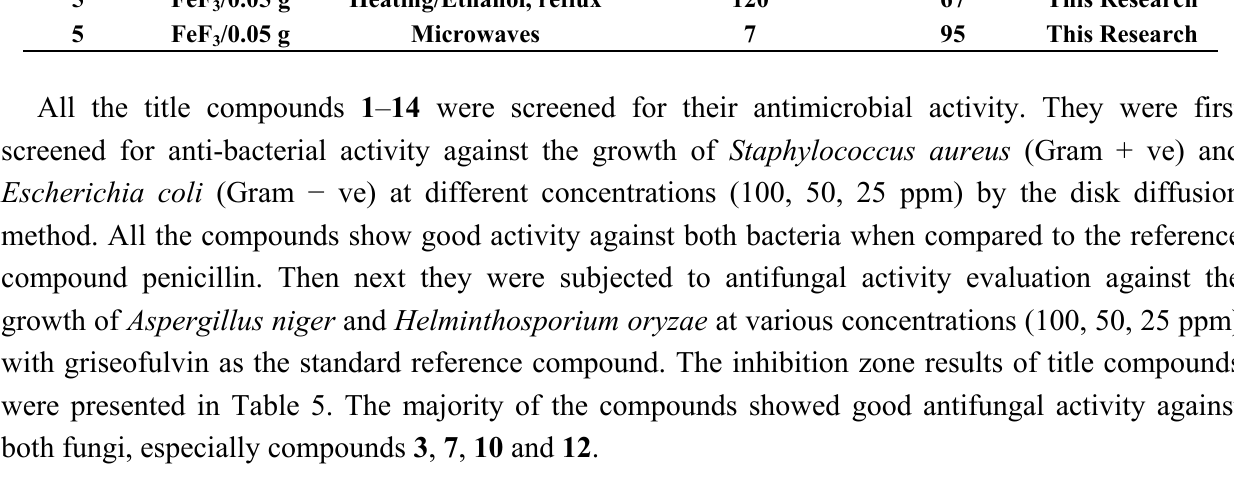
Table 5. Antimicrobial activity of the compounds 1 – 14